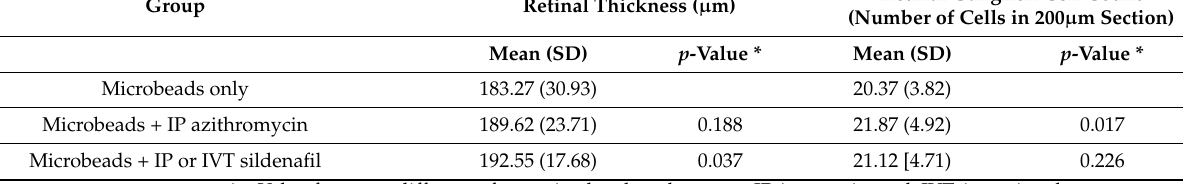
Right eyes from AZ- or sildenafil-treated groups were also compared with those of the microbead-only group. In the WT mice, injection of either AZ or sildenafil